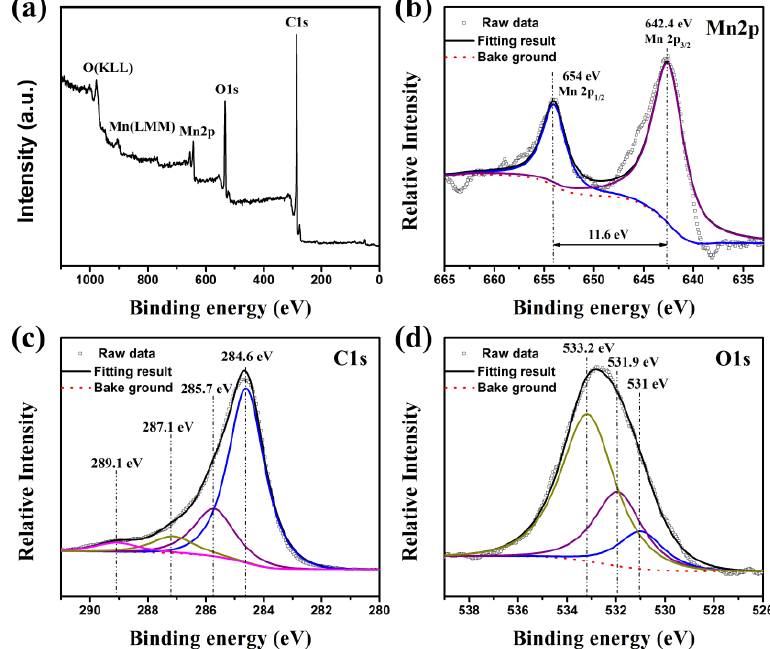
Figure 4. The XPS spectra of MnO 2 /BC hybrids: ( a ) Survey scan spectrum; ( b ) W 2p core level spectrum; ( c ) C 1s core level spectrum; ( d ) O 1s core level spectrum.